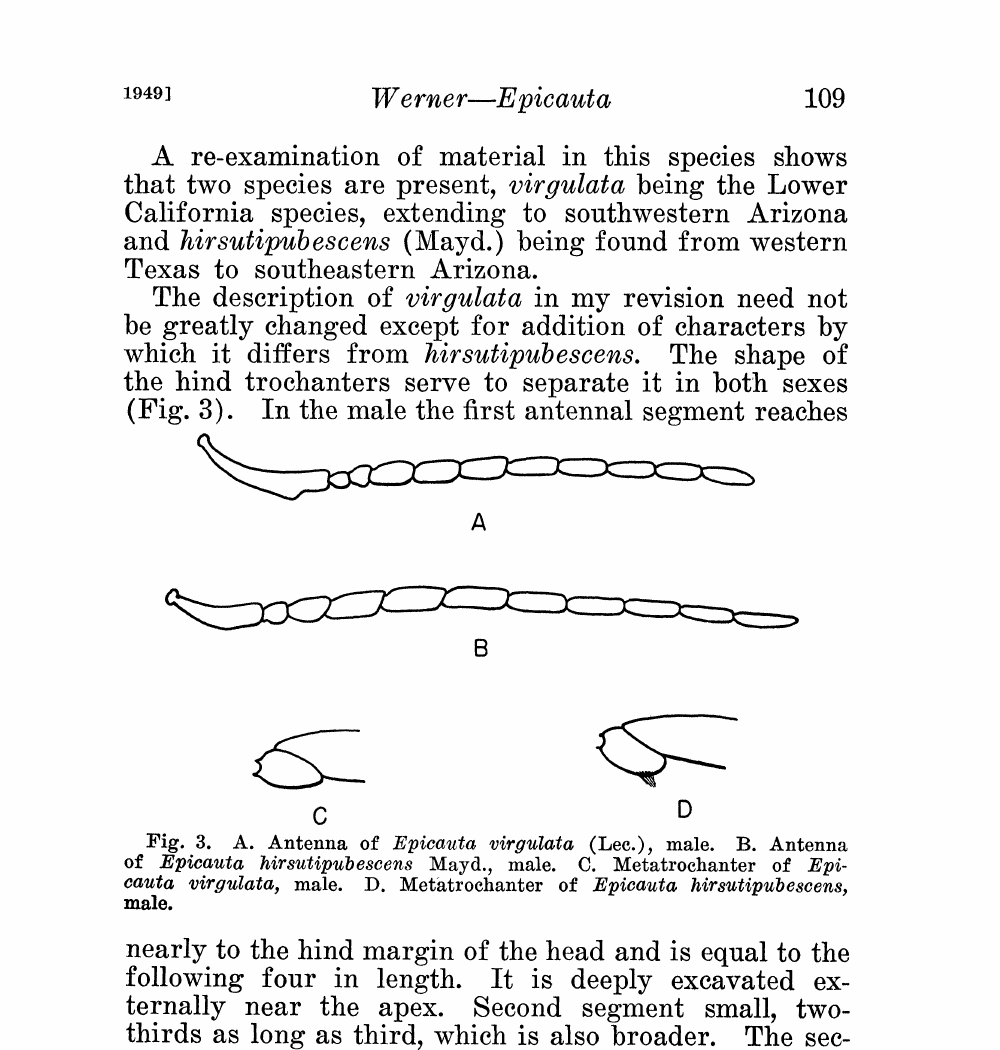
Fig. 3. A. Antenna of Epicauta virgulata (Lec.), male. B. Antenna of Epicauta hirsutipubescens Mayd., male. C. Metatrochanter of Epi- cauta virgulata, male. D. Metatrochanter of Epicauta hirsutipubescens,